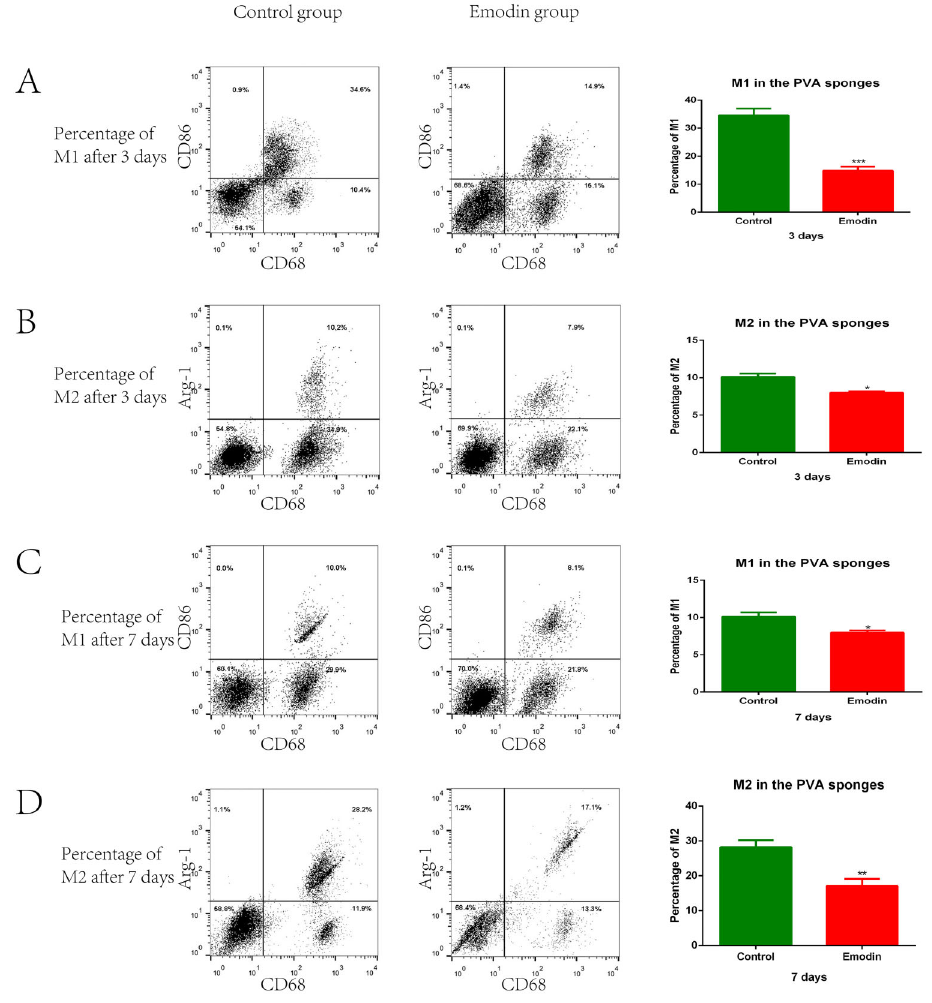
Figure 3. Emodin modulated in vivo M1 and M2 polarization of macrophages in implanted polyvinyl alcohol (PVA) sponges. A – D , The implanted PVA sponges were removed and assessed for M1 ( A and C ) and M2 ( B and D ) populations at 3 days ( A and B ) and 7 days ( C and D ) after implantation. The percentages of M1 and M2 macrophages and total macrophages in sponge exudates were determined by fl ow cytometry using the indicated markers. Representative fl ow pro fi les are shown (left), and the percentages of M1/M2 populations are summarized (right). Data are reported as means ± SE for n=3 for each group. *P,0.05, **P o 0.01, ***P o 0.001 vs the Control group (two-tailed t